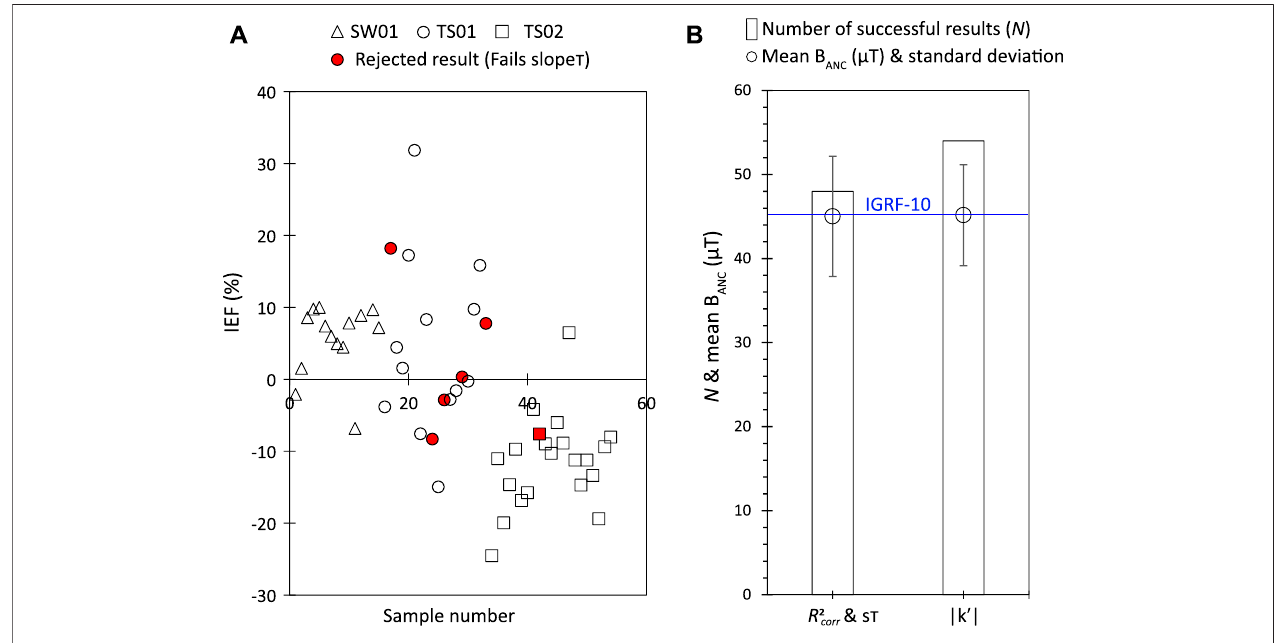
FIGURE4| Palaeointensityresultsofthetwovolcaniclava fl owsfromSakurajima,(YamamotoandHoshi2008).IGRFvaluesare45.7and46.0 µT. (A) Allindividual palaeointensity results using the current Shaw (LTD.)-DHT selection criteria. Results separated according to Yamamoto and Hoshi (2008). The only rejected results are duetoafailureoftheslope T criterion(highlightedinred).IEF(%)istheintensityerrorfraction (cid:1) (cid:1) m − µ µ X 100 (cid:3) ;m,estimatedmeangeomagnetic fi eldintensity;µ,expected geomagnetic fi eldintensitydeterminedfromIGRF-10data. (B) AcomparisonoftheresultswhenapplyingthesameShaw-DHTselectioncriteria;R 2 corr ≥ 0.990and